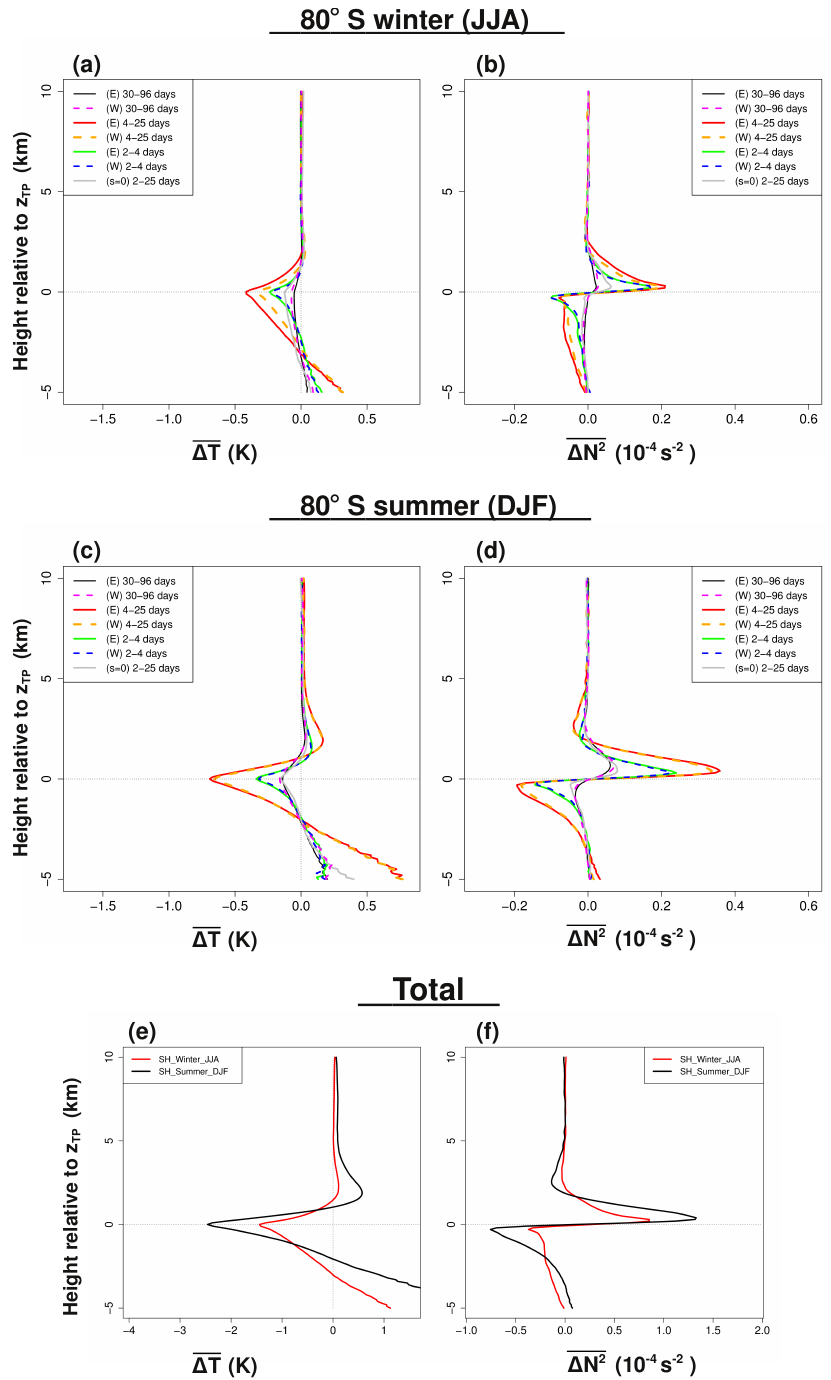
Figure 8. As in Figs. 4 and 6, but for 80 ◦ S.